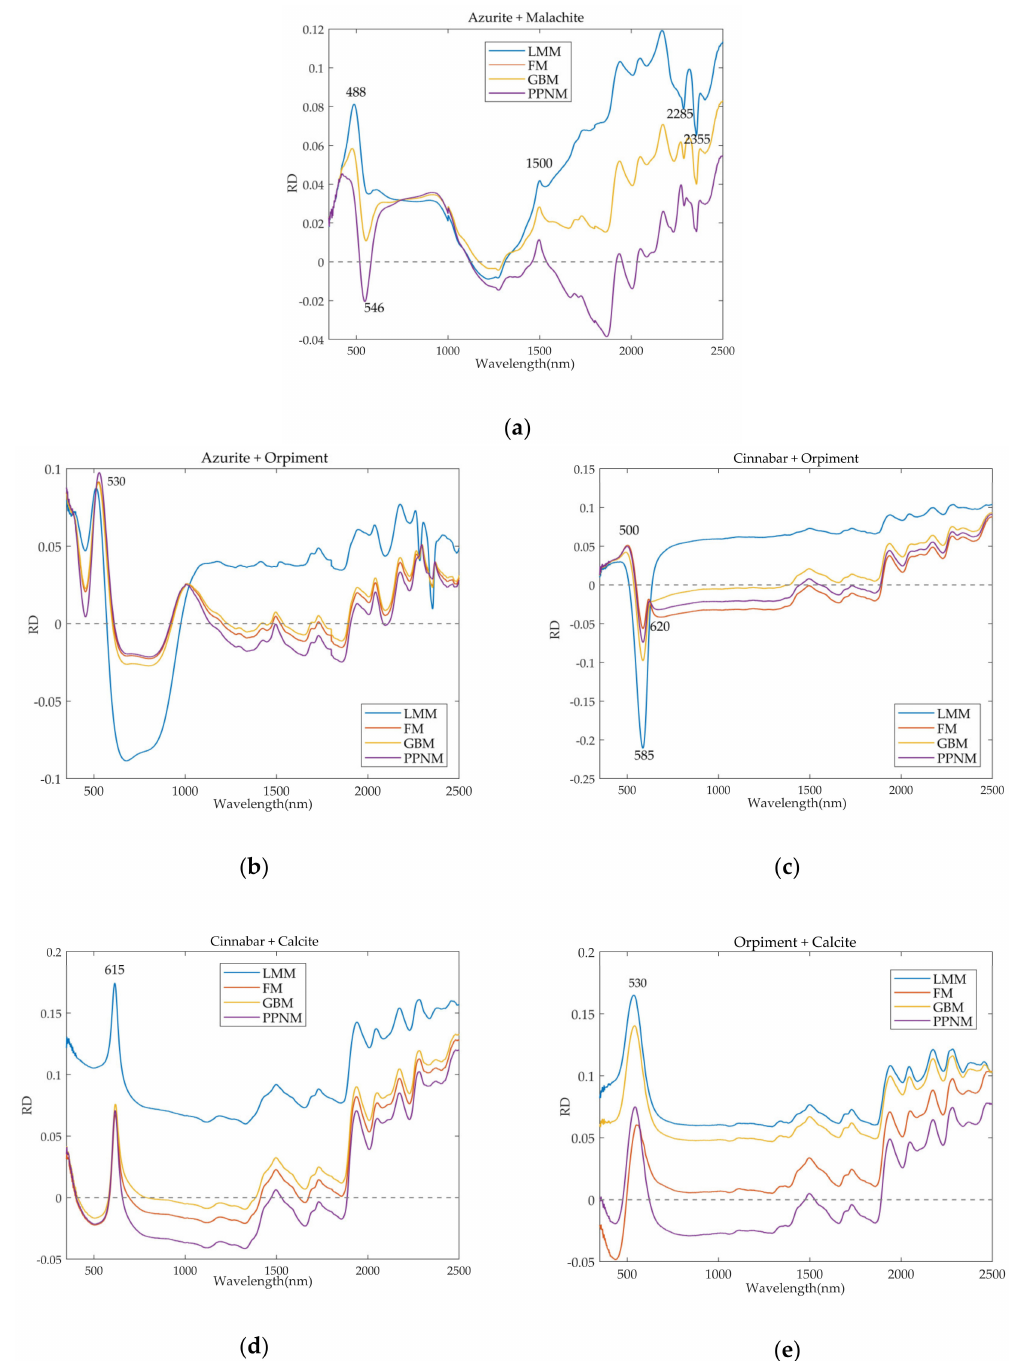
Figure 7. The mean reconstruction difference at different spectral bands for the five groups of mixed pigments: ( a ) azurite and malachite; ( b ) azurite and orpiment; ( c ) cinnabar and orpiment; ( d ) cinnabar and calcite; ( e ) orpiment and calcite. It can be seen from Figure 7 that the RD of the different pigment mixtures in different spectral bands is different, which reflects the different nonlinear degrees in the